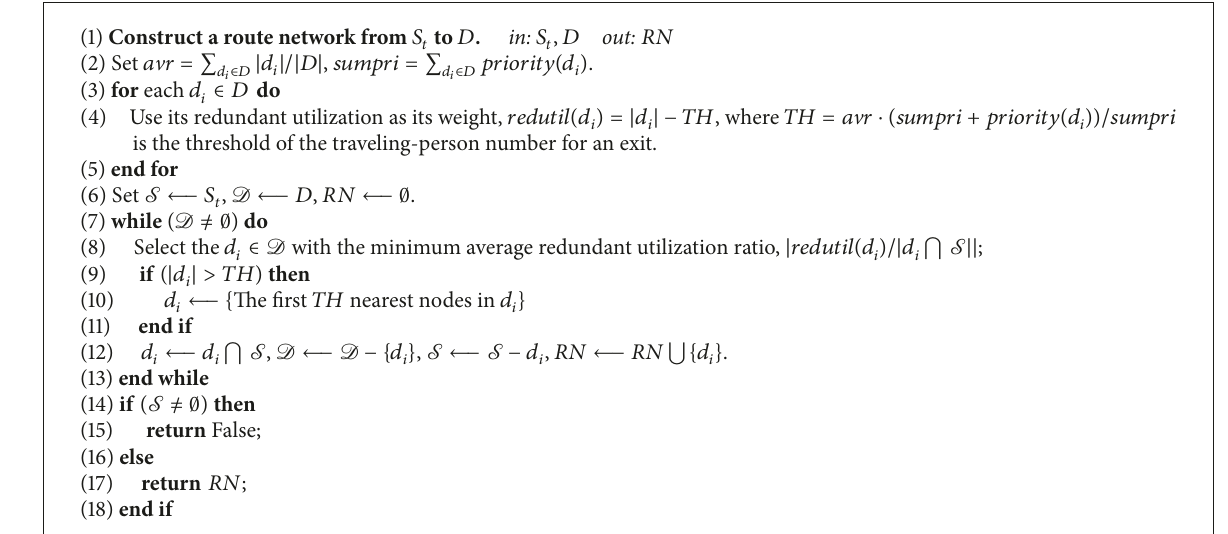
Algorithm 2: Function: RN-Greedy-MWSC